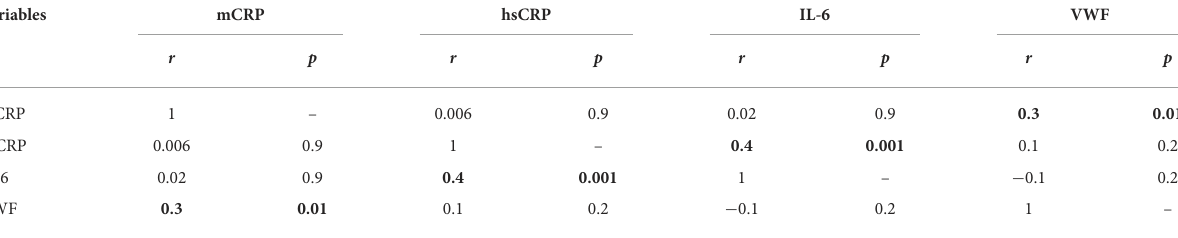
TABLE 3 The correlation matrix between mCRP and other biomarkers. Variables